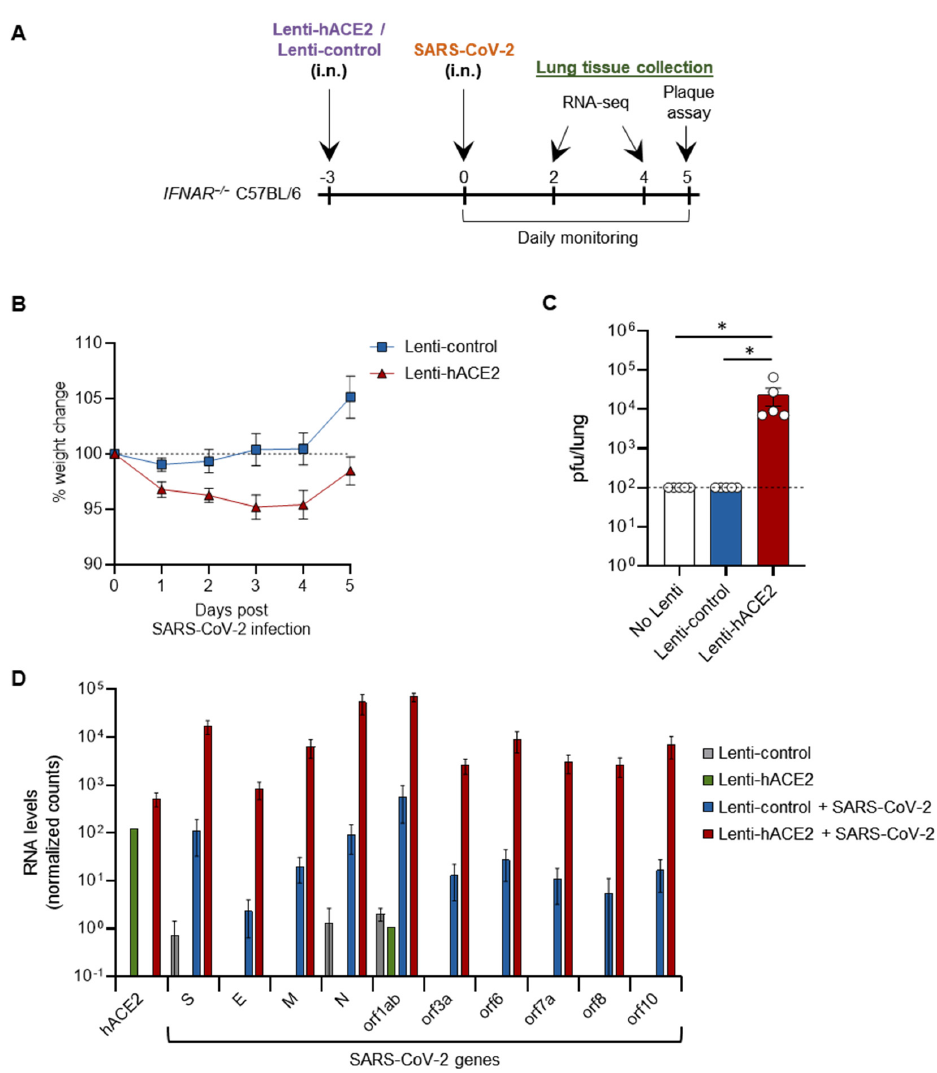
Figure 2. SARS-CoV-2 infection in Lenti-hACE2-transduced IFNAR − / − mice. ( A ) 12–14 weeks old IFNAR − / − C57BL/6 mice were intranasally transduced with hACE2 or control lentiviral vectors (Lenti-hACE2 and Lenti-control, respectively) and 3 days later infected intranasally with 2 × 10 5 pfu SARS-CoV-2. Mice body weight was monitored daily for 5 days post SARS-CoV-2 infection (dpi). Mice were sacrificed at 5 dpi for plaque assays, and at 2 and 4 dpi for RNA-seq analysis. ( B ) Weight of Lenti-hACE2 ( n = 5) and Lenti-control ( n = 5) mice infected with SARS-CoV-2 was recorded for 5 days. Values are presented as the mean ± SEM p < 0.01 according to the area under the curve (AUC) analysis. ( C ) Virus titers in the lung were determined on Vero E6 cells. Values are presented as the mean ± SEM, n = 5, * p < 0.05 according to one ‐ way ANOVA corrected for multiple comparisons. Dashed line represents the limit of detection. ( D ) hACE2 and SARS ‐ CoV ‐ 2 viral genes mean expression levels ± SEM calculated from RNA ‐ seq data of lung homogenates collected from Lenti ‐ control ( n = 2), Lenti ‐ hACE2 ( n = 1), Lenti ‐ control infected with SARS ‐ CoV ‐ 2 ( n = 2; 1 at 2 dpi and 1 at 4 dpi) and Lenti ‐ hACE2 infected with SARS ‐ CoV ‐ 2 ( n = 2; 1 at 2 dpi and 1 at 4 dpi) mice.